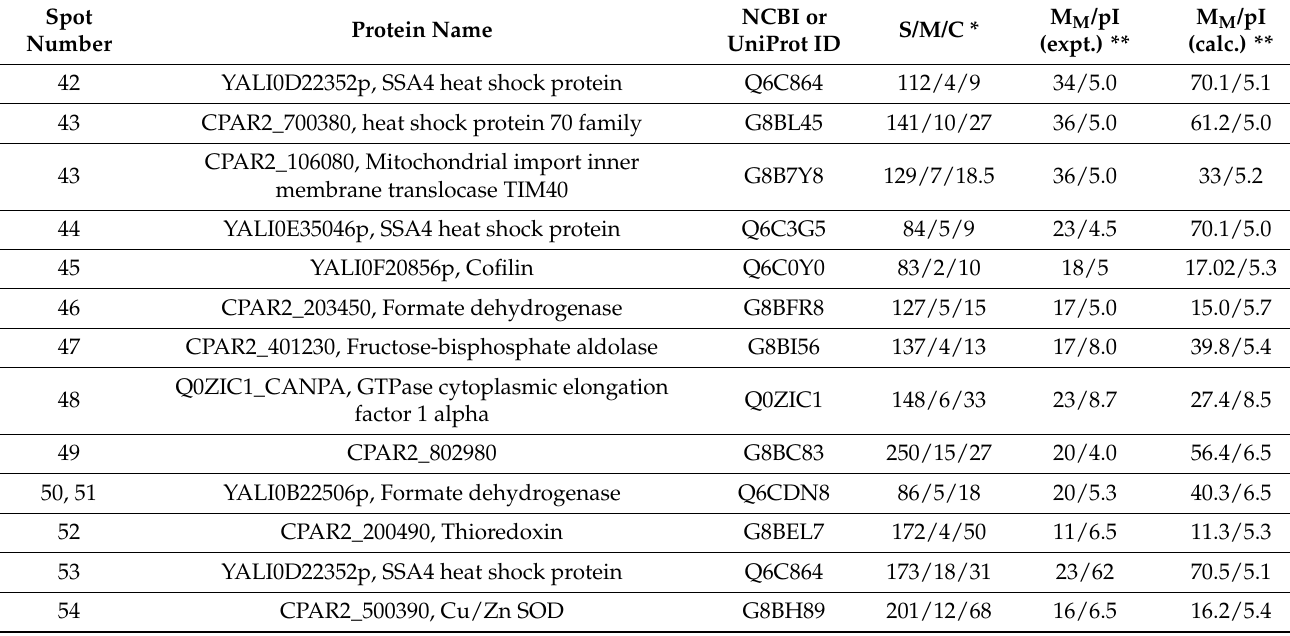
Table 5. List of differentially expressed proteins in response to heat stress in the Y. lipolytica yeast using mass spectrometry (MALDI-TOF MS and